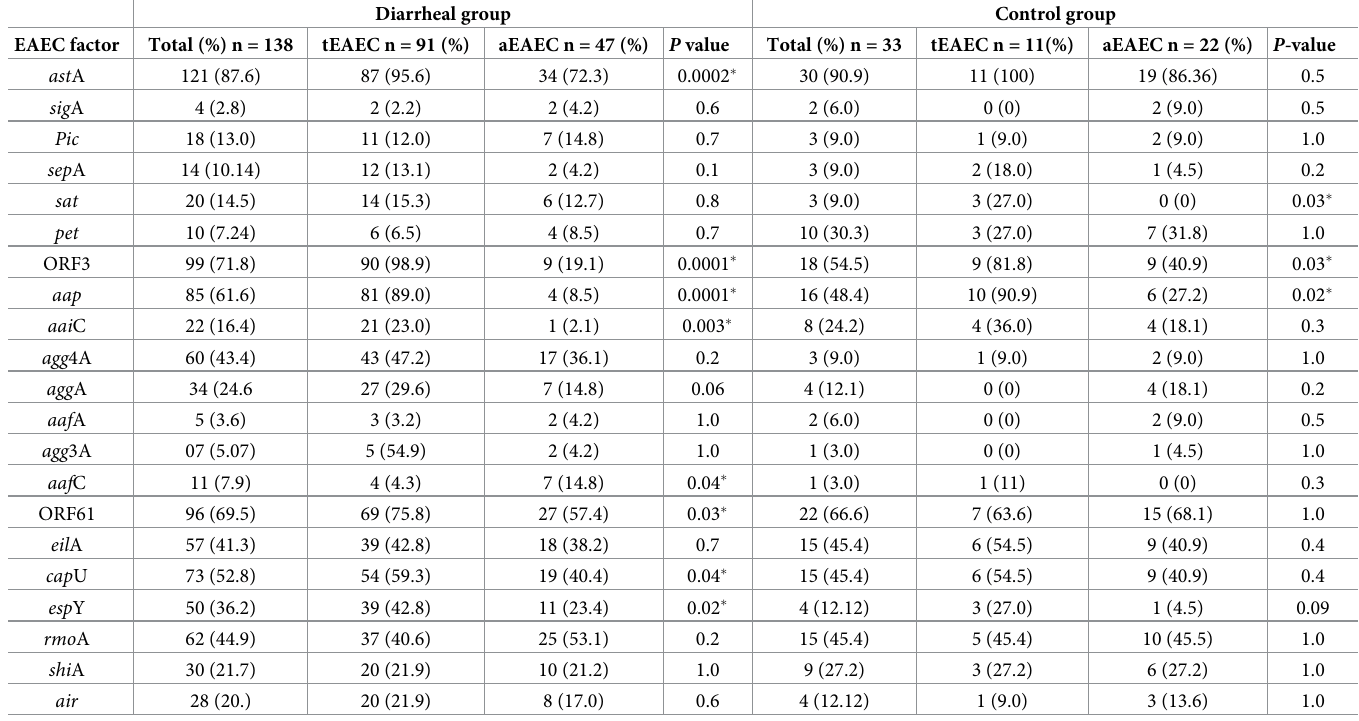
Table 8. Distribution of tEAEC and aEAEC virulence-related markers in the diarrheal